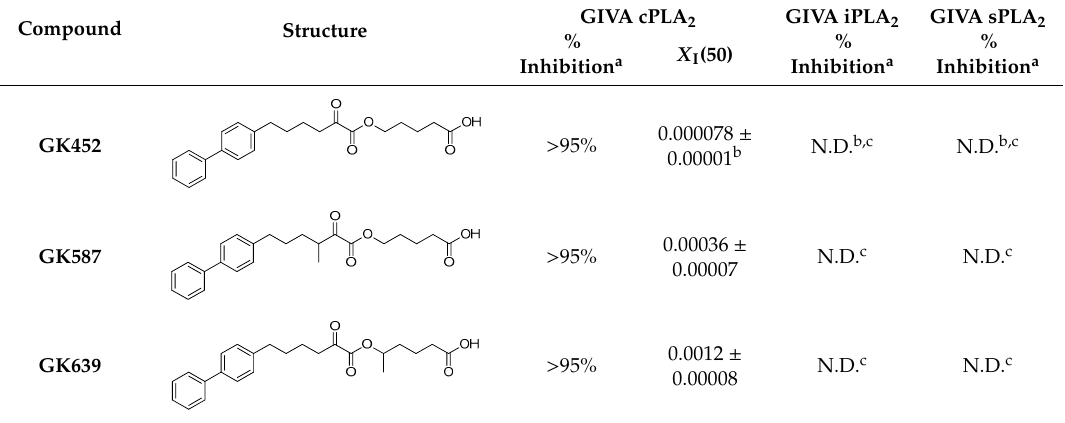
Table 1. In vitro Potency and Selectivity of Methyl Substituted 2-Oxoesters.